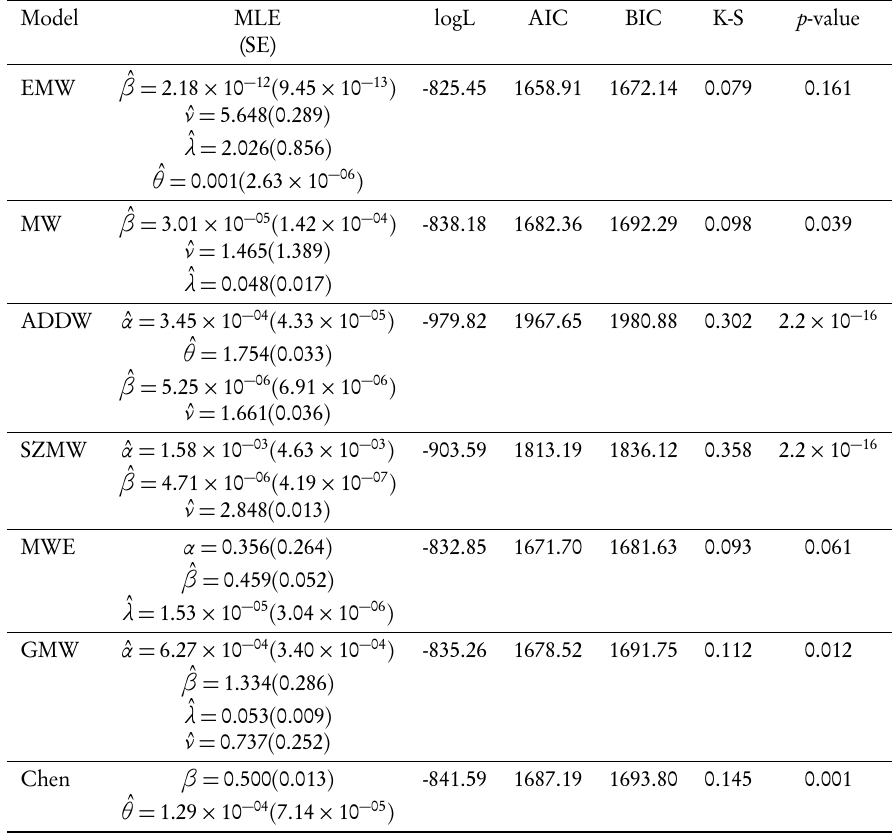
Fitting summary for the athlete’s data